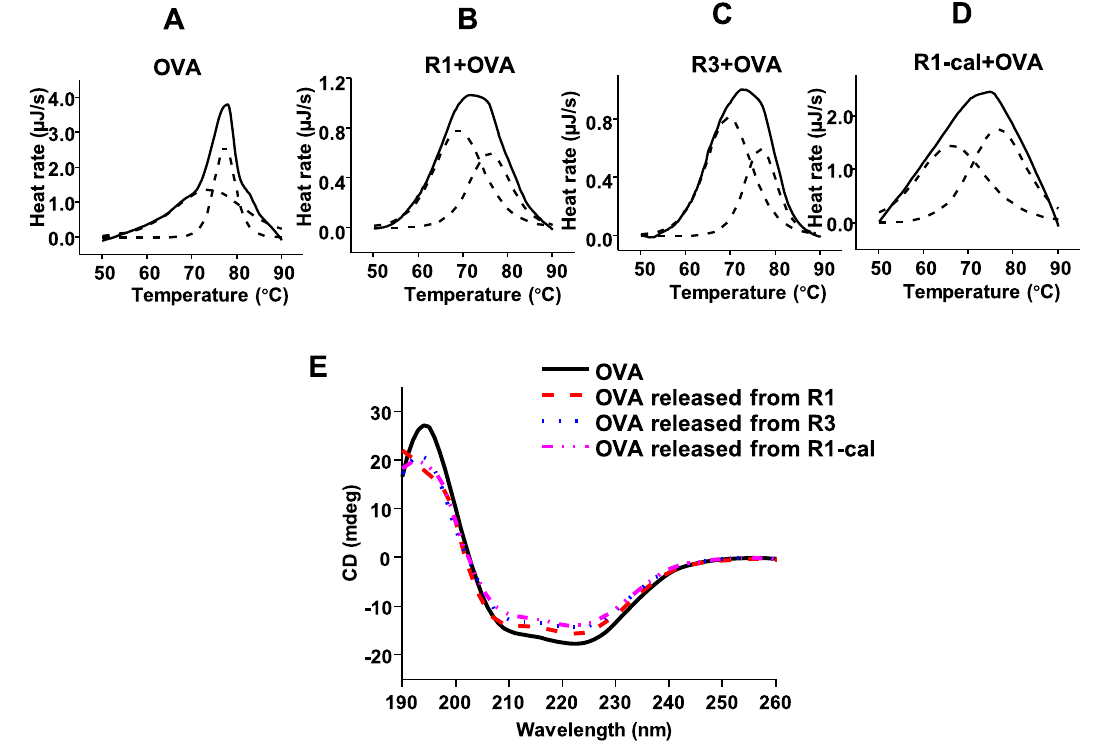
Fig. 7 Analysis of the in fl uence of AlOOH nanorods on the structure and stability of OVA. A – D Thermograms and peak fi ts (dashed line) obtained by DSC for OVA in solution and adsorbed by AlOOH nanorods. E CD spectra of native OVA and OVA released from AlOOH nanorods.